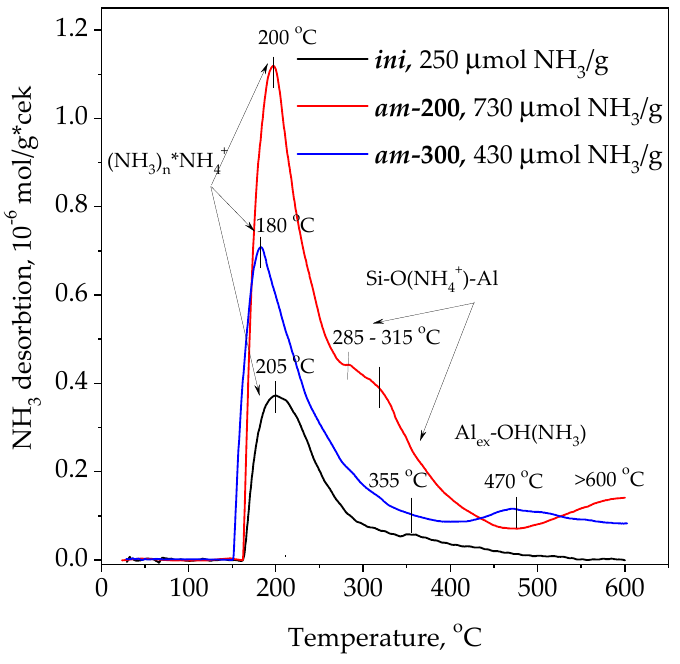
Figure 7. NH 3 TPD profiles of the samples ini- 200 , am- 200 and am- 300 . In addition, NH 3 TPD profiles of the modified samples are characterized by strongly adsorbed ammonia desorbed at higher temperatures: 285–315, 355 and 470 °C. It is believed that the higher the temperature of ammonia desorption, the stronger the site from which ammonia is desorbed. There is the wide shoulder at 285–315 °C, which corresponds to medium-strong sites for the am -200 sample. Taking into account the IR absorbance bands at 3657 and 3580 cm − 1 (Figure 6), these sites can be bridging OH groups in large cavities and sodalite cages of LSX. Its intensity in terms of the concentration of ammonia molecules is 213 µmol/g of the sample. The intensity of the shoulder is much lower in the case of the am- 300 sample (about 15 µmol/g of the sample), but the small maximum at 470 °C is observed in this case. Strong acidity of the latter could be related to hydroxy groups in the composition of amorphous extra-framework aluminosilicate [23] or Al ex –OH [23,88,90] fragments. At elevated temperatures, a portion of the bridging proton groups are removed, which is accompanied by the extraction of Al 3+ cations from the zeolite framework, the formation of Lewis acid sites and terminal Si–OH groups, as well as the loss of crystallinity [23] as shown by XRD. The slow desorption of ammonia from ini and am -300 samples in the temperature range of 250 to 360 °C is associated with a change in the acidity of their proton sites (Figure 7). The acidity increases with a decrease in total concentration of BASs [87,89] and an increase in the proportion of extra-framework Al 3+ [23], but it decreases in the presence of alkaline cations [23,88]. The ammonia desorption at temperatures above 500 °C is usually associated [23] with irreversible ammination of extra-framework Al–OH and Si–OH groups during NH 3 TPD. This process is enhanced for the am -200 sample, as it adsorbs more ammonia during its pretreatment (Figure 7). Thus, concluding the analysis of NH 3 TPD, the BAS content in the am -200 sample does not exceed three centers per unit cell; calculations show that 1 g of zeolite contains 74 µmol of UCs with composition Na 32 K 12 (NH 4 ) 52 Al 96 Si 96 O 384 . In addition to the spectra of am -200 and am -300 samples, Figure 6 illustrates differ- ence IR spectra ( am -200-ads and am -300-ads ) obtained by subtracting spectra of samples before pyridine adsorption from the corresponding spectra taken after its adsorption at 150 °C. Difference spectra reveal bands at 1490, 1540 and 1637 cm − 1 , which correspond to pyridinium ions [91,92] and are an indicator of the proton sites in the sample under study.